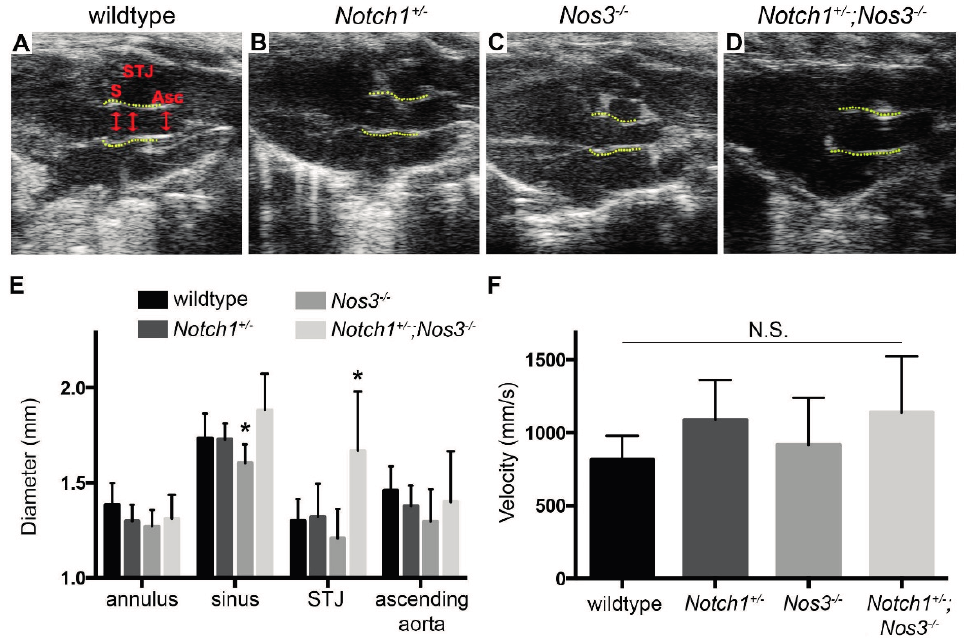
Figure 2. Loss of sinotubular junction in Notch1 +/ − ; Nos3 − / − mice.